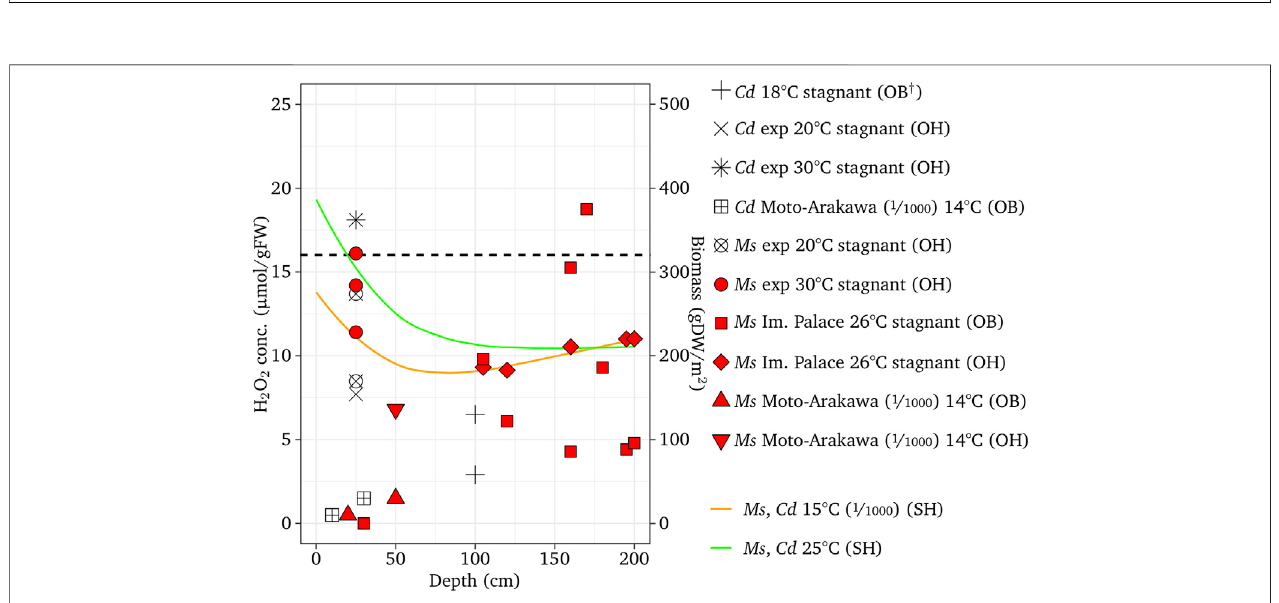
FIGURE 6 | Simulated H 2 O 2 concentration with respect to the river depth for the channel slopes of 1/300 or stagnant water condition, and different temperature, comparedwiththeH 2 O 2 concentrationand biomassofexperiments at theEnoand Sabarivers. ‘ OH ’ , ‘ OB ’ and ‘ SH ’ designate observedH 2 O 2 ,observedbiomass, and simulated H 2 O 2 , respectively.